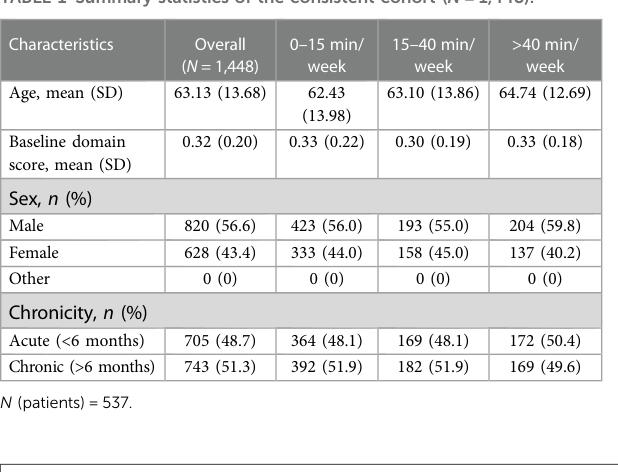
TABLE 1 Summary statistics of the consistent cohort ( N= 1,448).